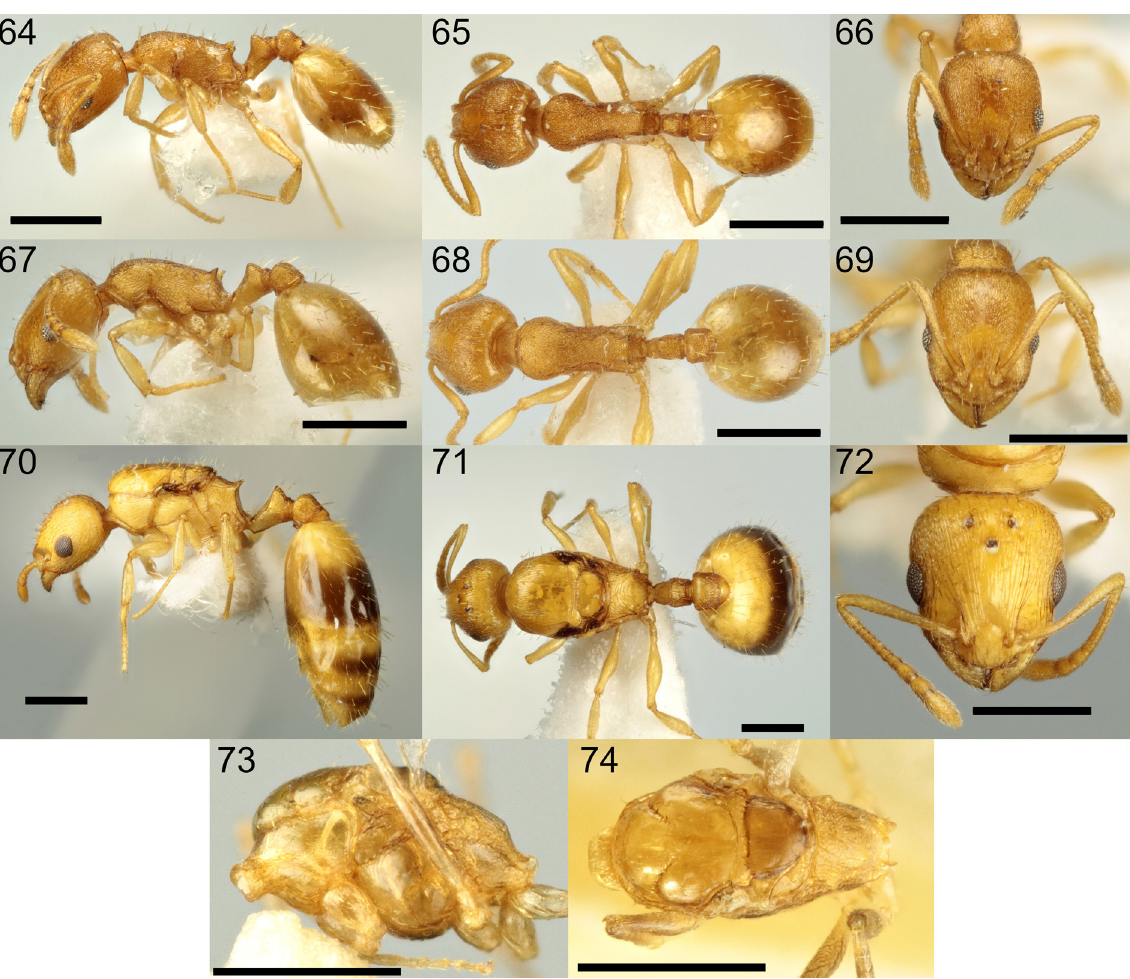
Figs 64–74. Specimens of Temnothorax vivianoi Schifani, Alicata & Prebus sp. nov. in lateral (left), dorsal (center) and head view (right). Photos by Enrico Schifani, available on www.antweb.org, specimen identifiers in parentheses. 64–66 . Holotype worker from Monte Pellegrino (Palermo Mountains, Sicily)